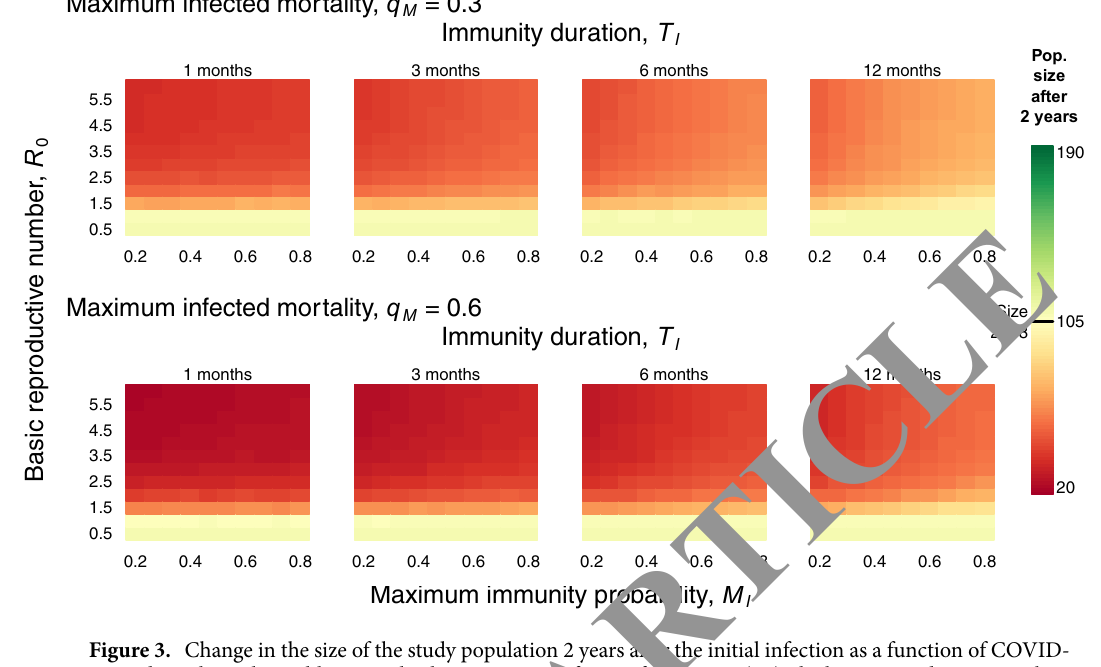
Figure 3. Change in the size of the study population 2 years after the initial infection as a function of COVID- 19 epidemiological variables, namely, the maximum infection fatality rate ( q M ), the basic reproductive number ( R 0 ), the maximum immunity probability ( P I ), and the immunity duration in months ( T I